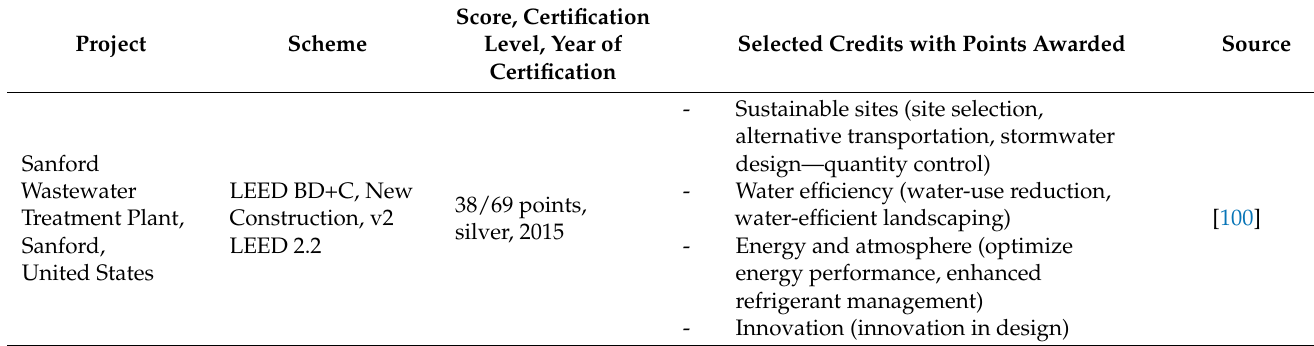
Table 2. Data on LEED certification for selected facilities related to wastewater treatment plants.